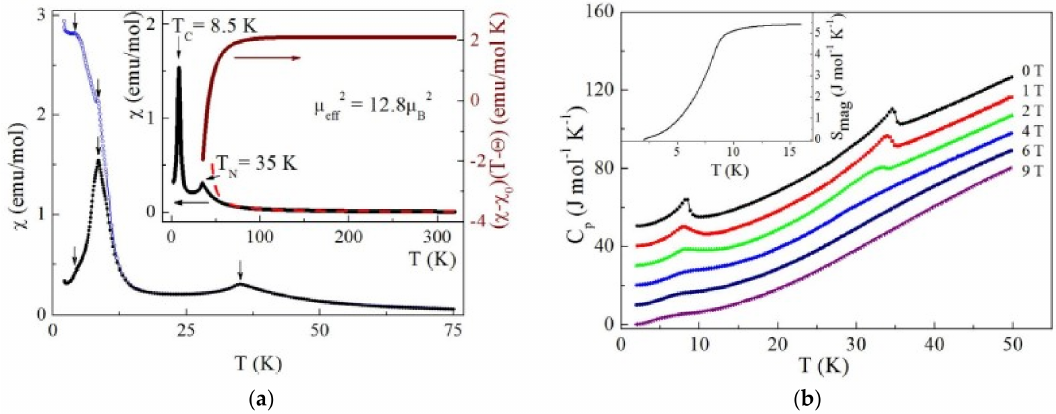
Figure 18. ( a ) The temperature dependences of magnetic susceptibility in Cu 3 Sm(SeO 3 ) 2 O 2 Cl in ZFC (squares) and FC (circles) regimes taken at B = 0.02 T. Inset: The ZFC curve in the range 2–320 K and its fit (dash). Also shown is the temperature dependence of Curie constant C = ( χ − χ 0 )(T − Θ ). ( b ) The temperature dependences of specific heat in selected magnetic fields for Cu 3 Sm(SeO 3 ) 2 O 2 Cl. Inset: Temperature dependence of magnetic entropy S mag Reprinted figures with permission from [34]. Copyright (2016) by the American Physical